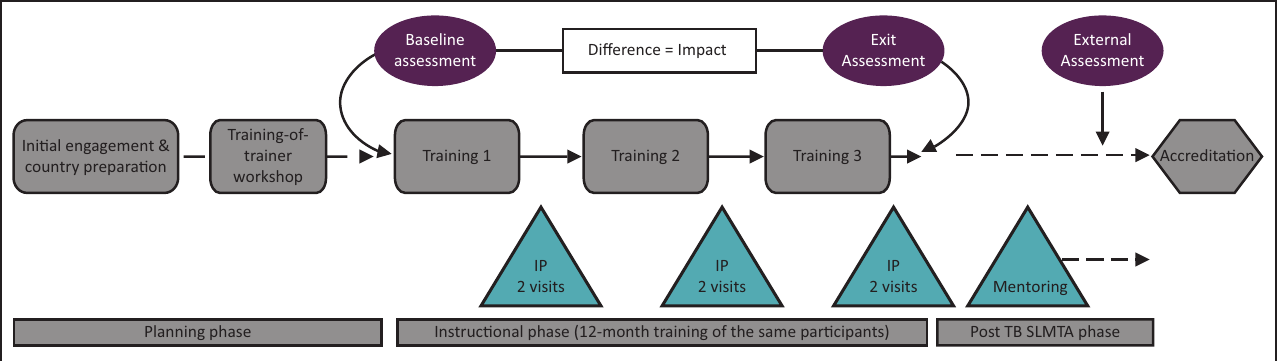
FIGURE 1: Diagrammatic representation of the TB SLMTA programme from initiation to